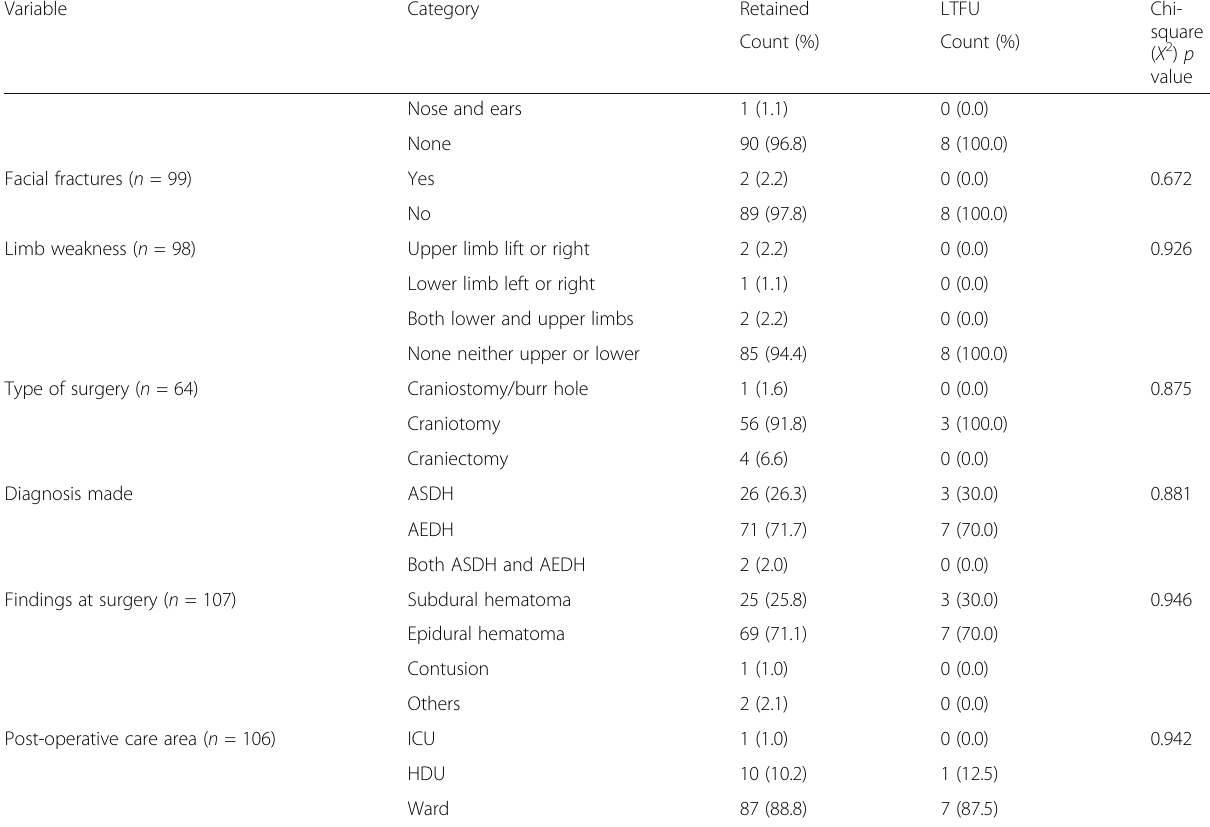
Table 4 Comparison of the baseline characteristics between retained and LTFU patients (Continued)